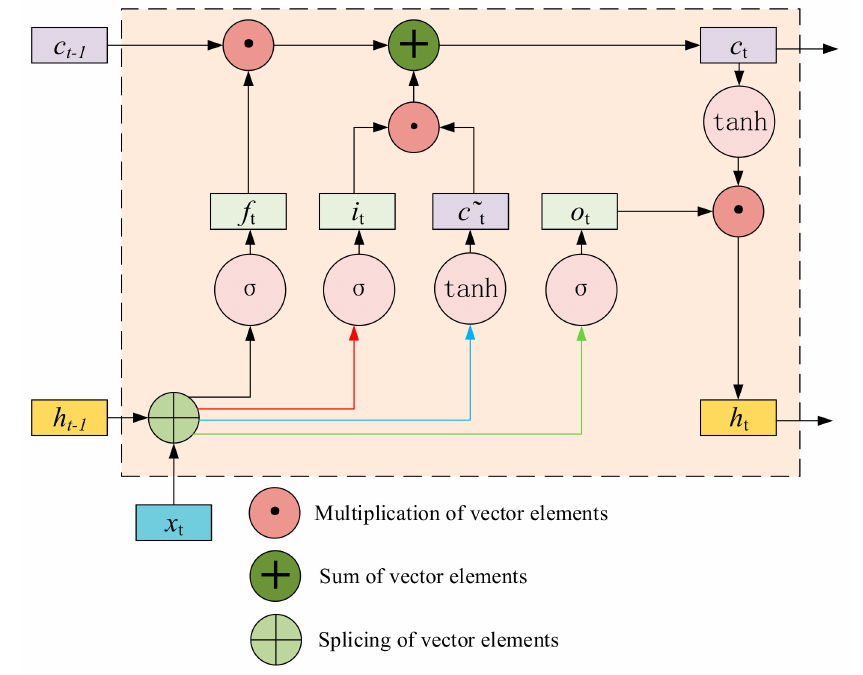
Figure 1. Reconstructed samples of a noisy voiced